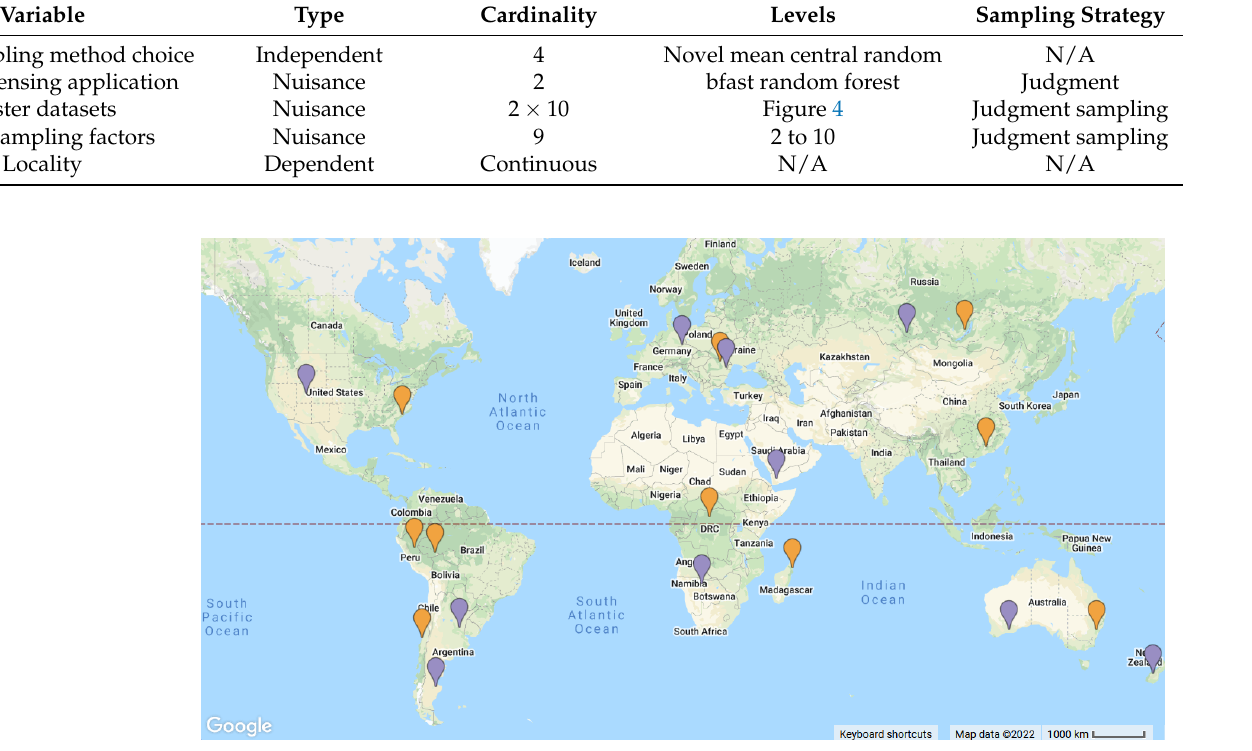
Figure 4. Locations of datasets used as input for bfastmonitor (orange) and random forest